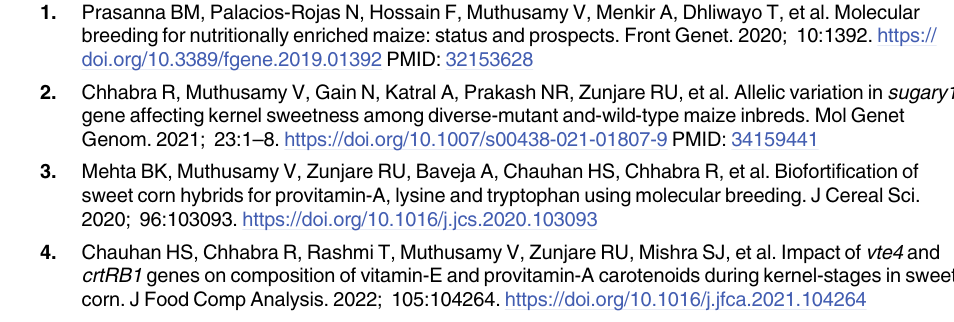
S1 Fig. Evolutionary relationship of SH2 protein in maize and its orthologues in selected monocots. (TIF) S2 Fig. Domains in SH2 protein; (a) in SH2-AAB52952.1 protein and (b) Comparison of SH2 protein mutants and wild inbreds. (TIF) S3 Fig. (a) Secondary structure prediction and (b) FoldIndex and disorder in SH2 protein.